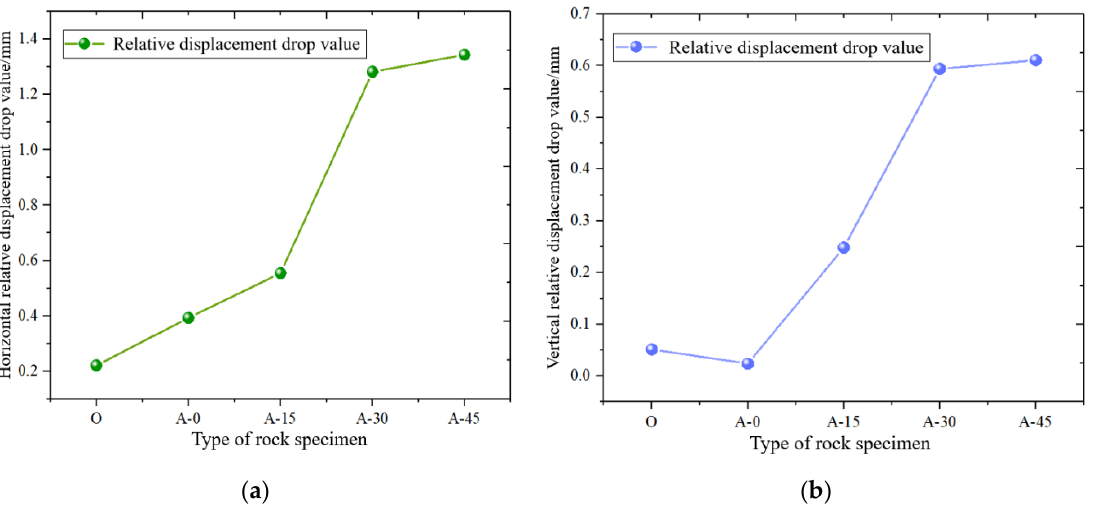
Figure 16. The displacement truncation difference of different types of rock samples of group A; ( a ) Horizontal displacement; ( b )Vertical displacement.